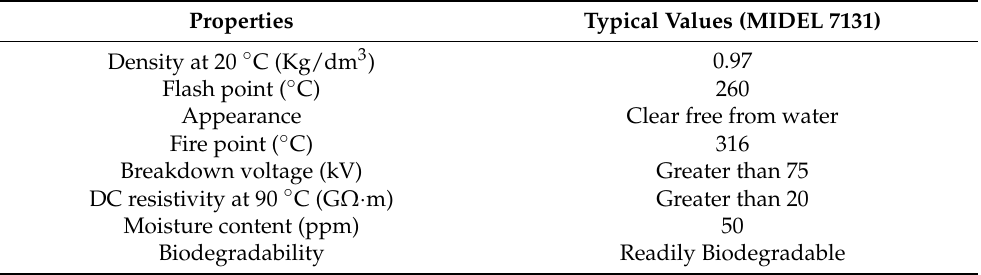
Table 2. Characteristics of Synthetic Ester